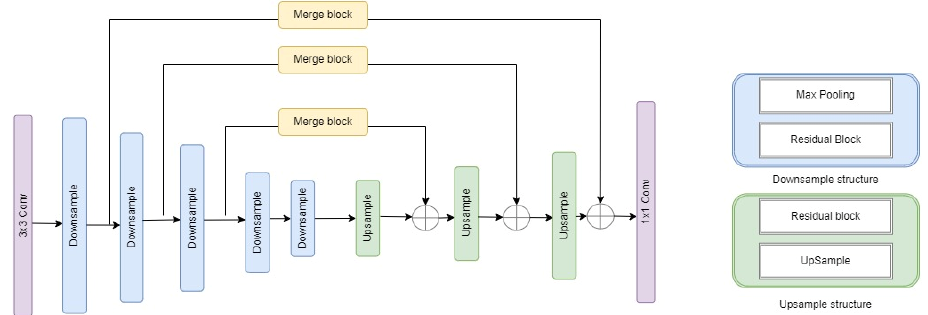
Figure 3. Hourglass structure used in candidate license plate detection and precise license plate detection.